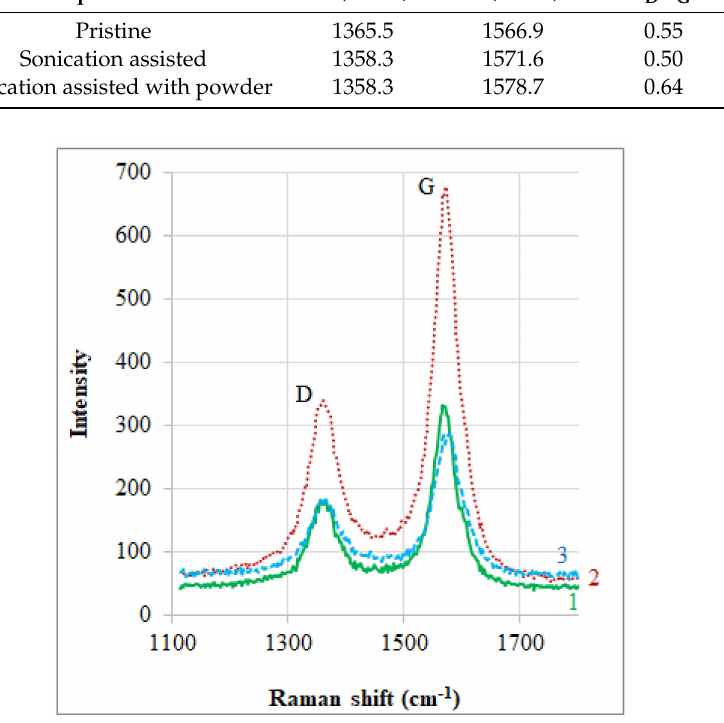
Figure 4. Raman spectra taken, first order region, from pristine MWCNT (No. 1 in green), assisted sonication MWCNT (No. 2 in red), and assisted sonication Al-1 vol. % MWCNT (No. 3 in